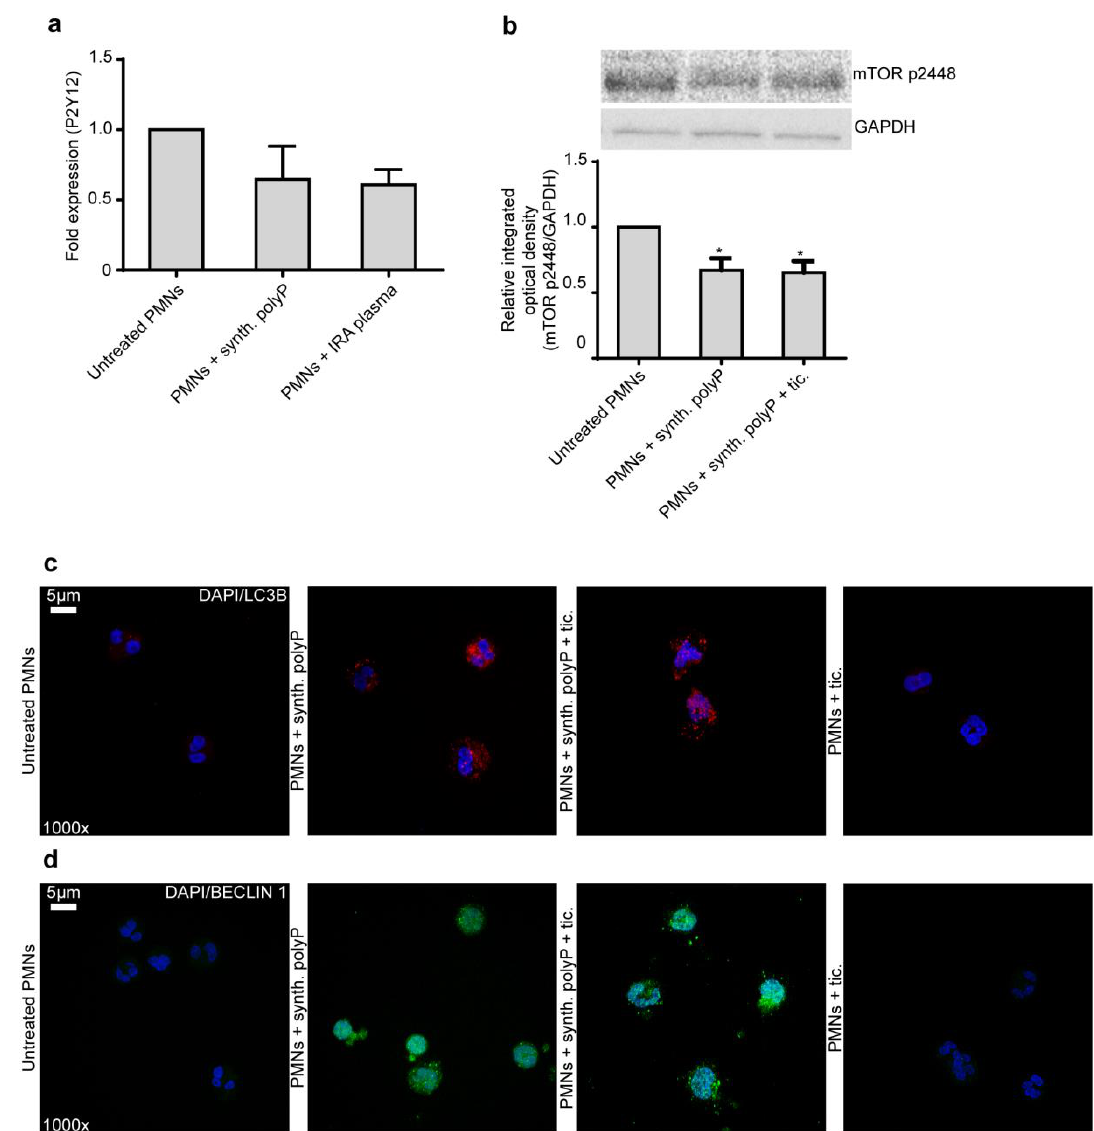
Figure 4. Ticagrelor does not signal through the P2Y12 or the autophagy pathway in neutrophil. ( a ). mRNA fold expression for P2Y12 receptor in control neutrophils treated with synthetic polyP and IRA plasma. Data from three independent experiments presented as mean ± SD. There is no statistical significance. ( b ). Western blot of mTOR p2448 in control neutrophils treated with synthetic polyP, with or without pre-treatment with Ticagrelor. One representative out of four independent experiments is shown. Relative integrated optical density was calculated compared to untreated PMNs value. Data from four independent experiments presented as mean ± SD. Statistical significance * p < 0.05. All conditions were compared to untreated/control conditions and statistical significance is indicated by the symbol “*”. ( c , d ). Confocal microscopy for DAPI/LC3B or DAPI/BECLIN 1 staining in control neutrophils treated with synthetic polyP, with or without pre-treatment with Ticagrelor. One representative out of six independent experiments is shown. Original magnification: 1000 × , Scale bar: 5 µ m. Blue: DAPI. Red: LC3B. Green: BECLIN 1. Polymorphonuclear neutrophils